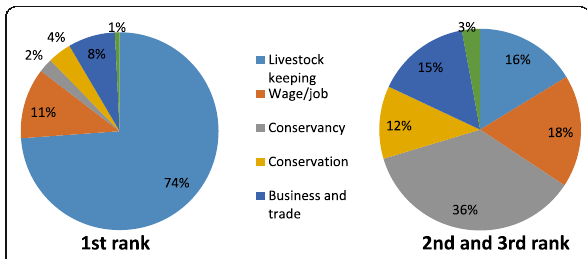
Figure 5 Perception of the importance of different livelihood activities to household welfare - conservancy members only ( n =